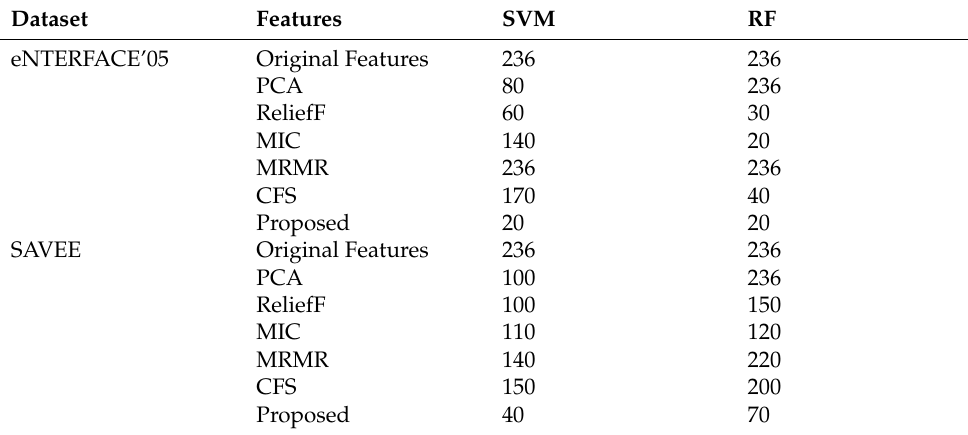
Table 2. Minimum feature dimensions required for each method